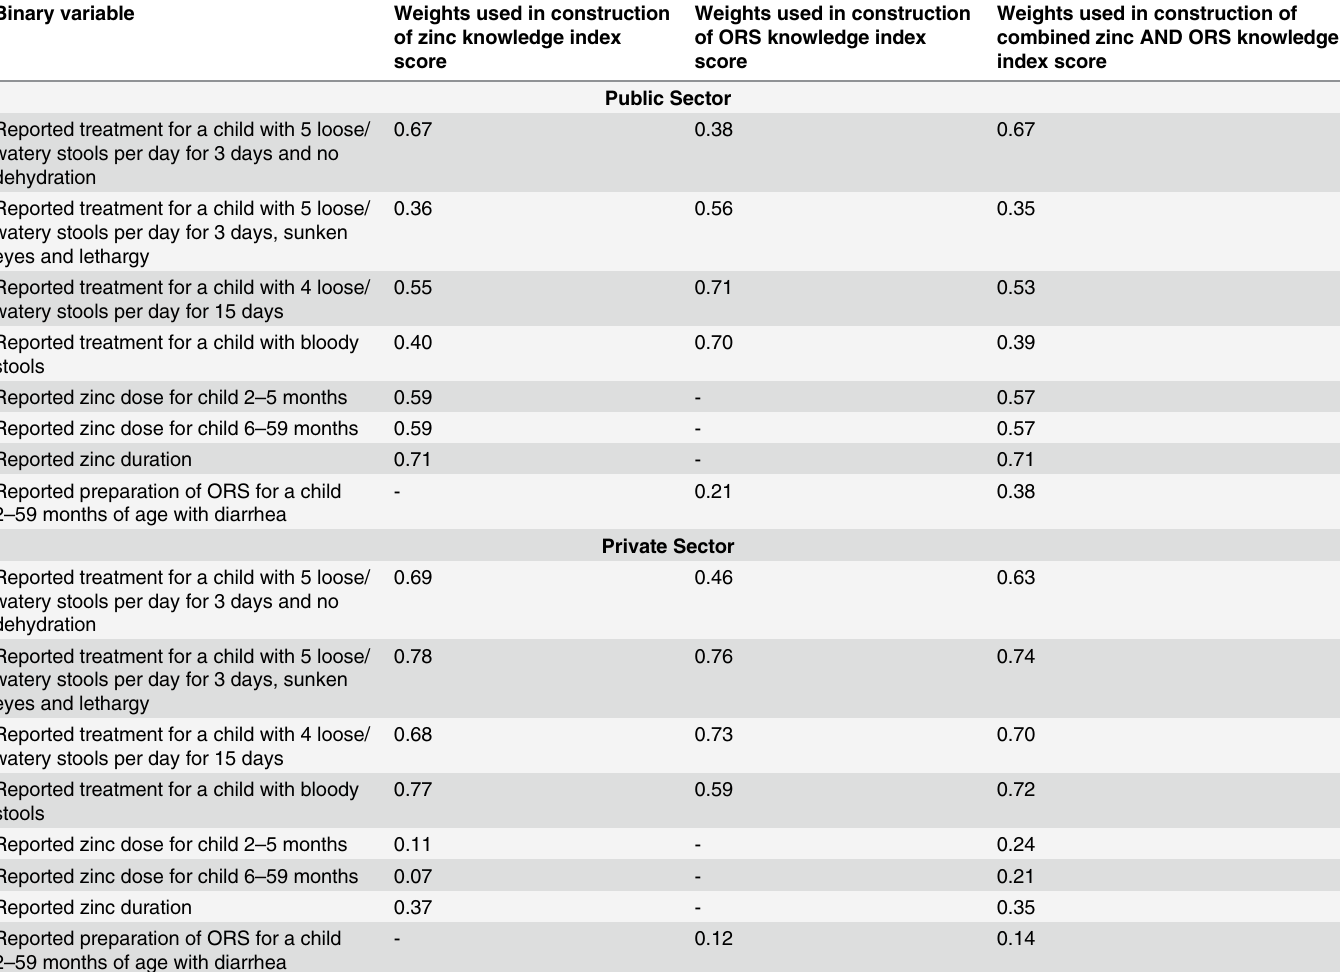
Table 3. Results of principal components analysis (PCA) for public and private sector models.